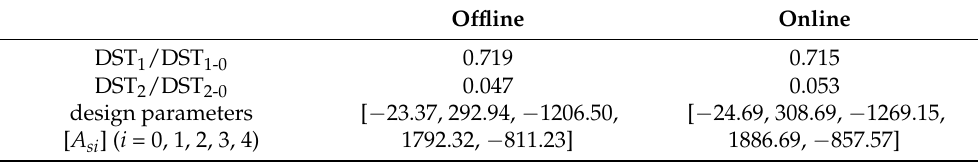
Table 7. Comparison of optimisation details between offline mode and online mode.